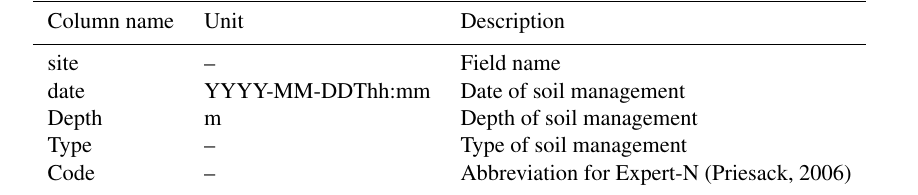
Table 7. Determined variables and description of the soil management data files